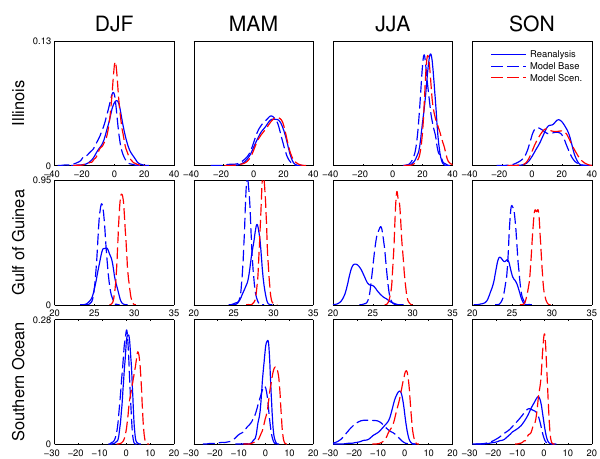
Figure 3. Marginal densities (by season) of daily mean tempera- ture ( ◦ C) for the pixels in Illinois (top row), the Gulf of Guinea (middle row), and the Southern Ocean (bottom row) for reanalysis data (solid blue line), baseline model output (dashed blue line), and scenario model output (dashed red line). The model output does not replicate the marginal distributions of the reanalysis observations. Furthermore, the marginal distributions in the model output change from the baseline to scenario